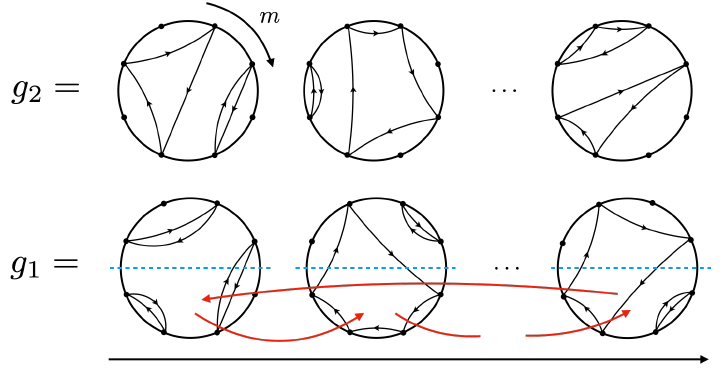
Figure 9 . A graphical representation of the elements lying on the geodesics Γ( g A , e ) and Γ( g B , e ) . An element g Γ( g ) consists of products of non-crossing permutations acting within each 2 ∈ B , e circle; whereas an element g Γ( g ) is similar to g , but is additionally conjugated by the twist 1 ∈ A , e 2 operator γ τ